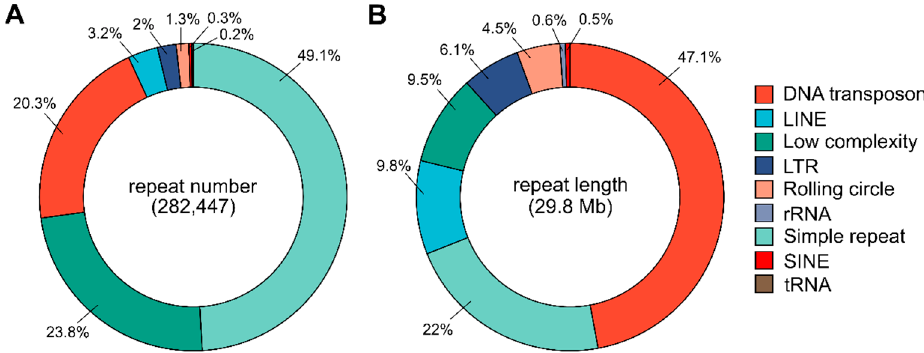
Figure 5. Composition of repeat elements in the T. freemani Tfree1.0 genome assembly. ( A ) The pro- portion of repeat classes in the total number of annotated repeats. ( B ) The proportion of repeat classes in the cumulative length of annotated repeats. Values are obtained by RepeatMasker annotation analysis and are shown in Table S5.